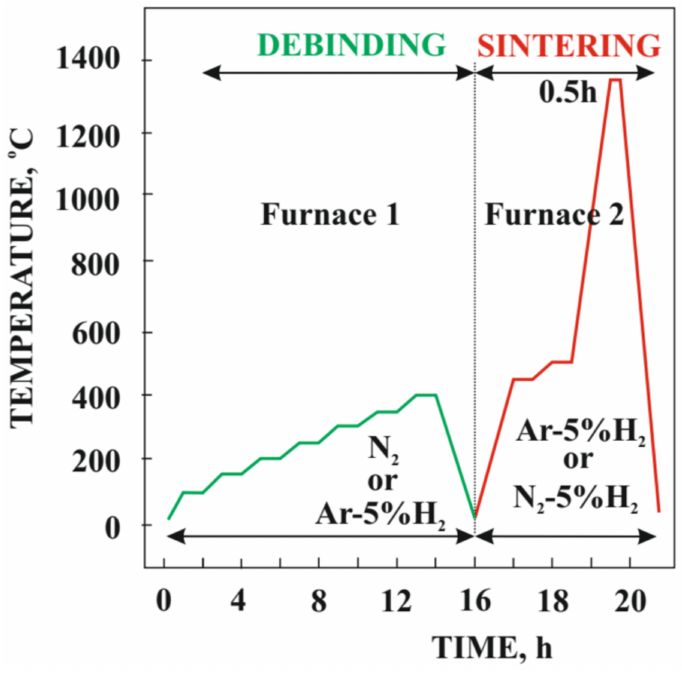
Figure 1. Heat treatment